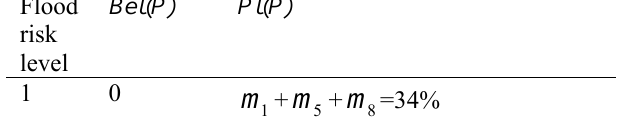
Table 6. Belief and plausibility value of urban flood risk